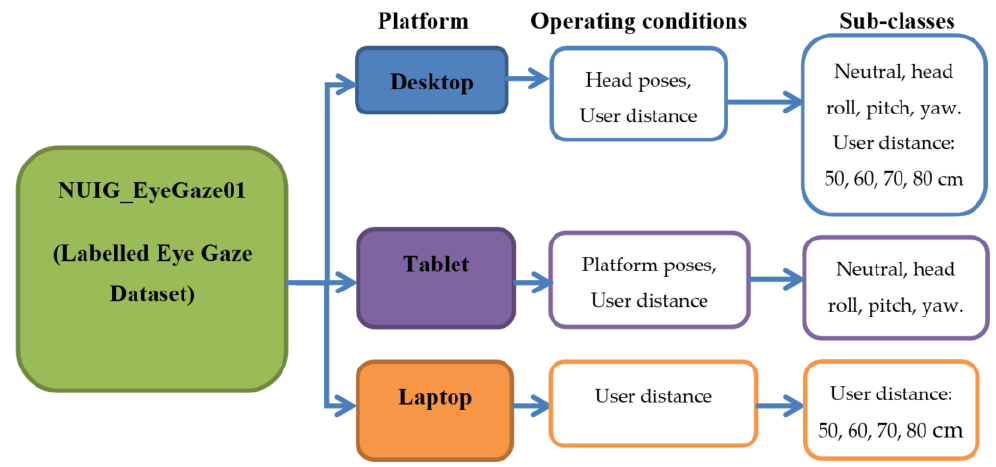
Figure 14. Snapshot of the NUIG_EyeGaze01 repository on Mendeley data.